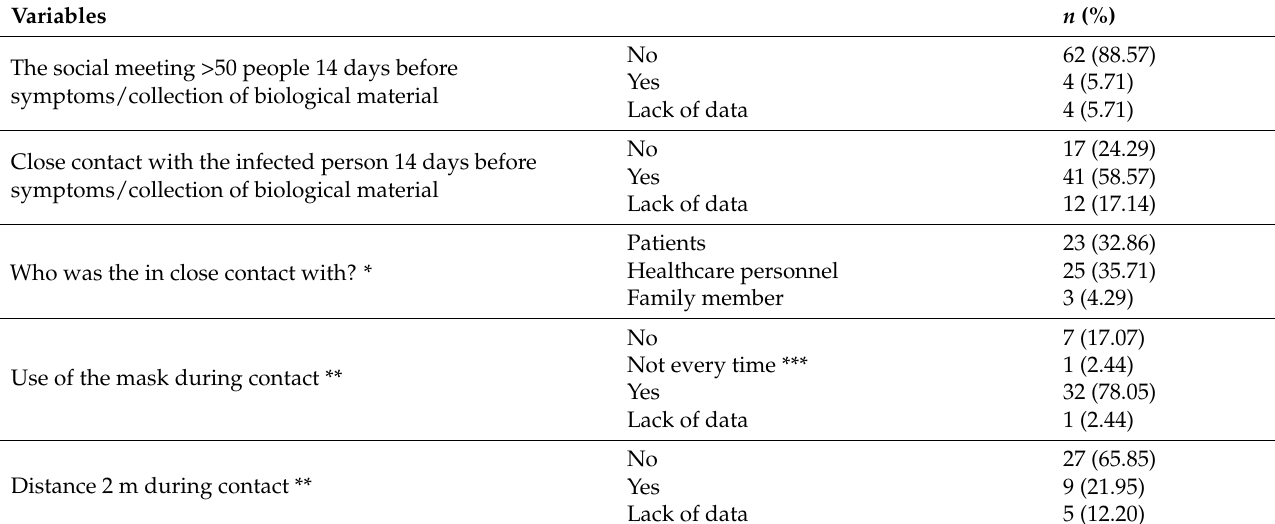
Table 4. Risk factors associated with in-hospital infection of COVID-19 observed in study group ( n = 70). Variables n